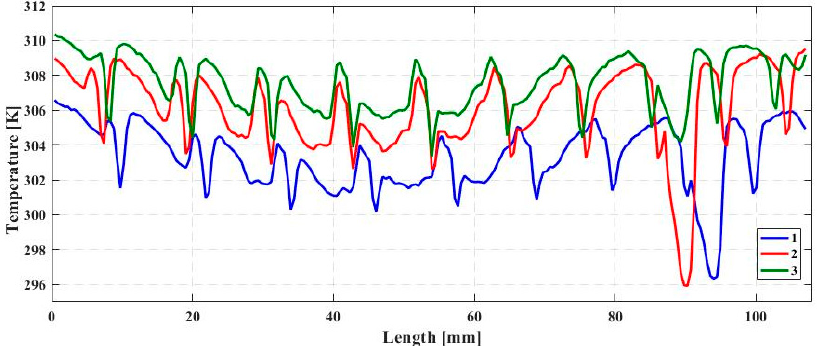
Figure 5. Temperature distributions along the selected lines (see Figure 4).